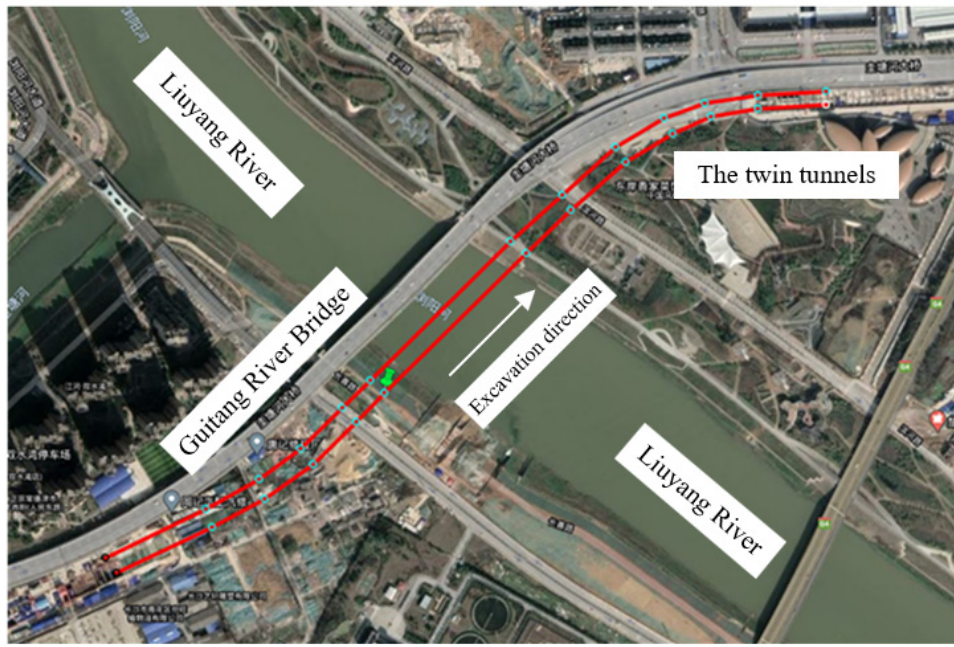
Figure 1. Location of the Liuyang River, the Guitang River Bridge and the tunnels.